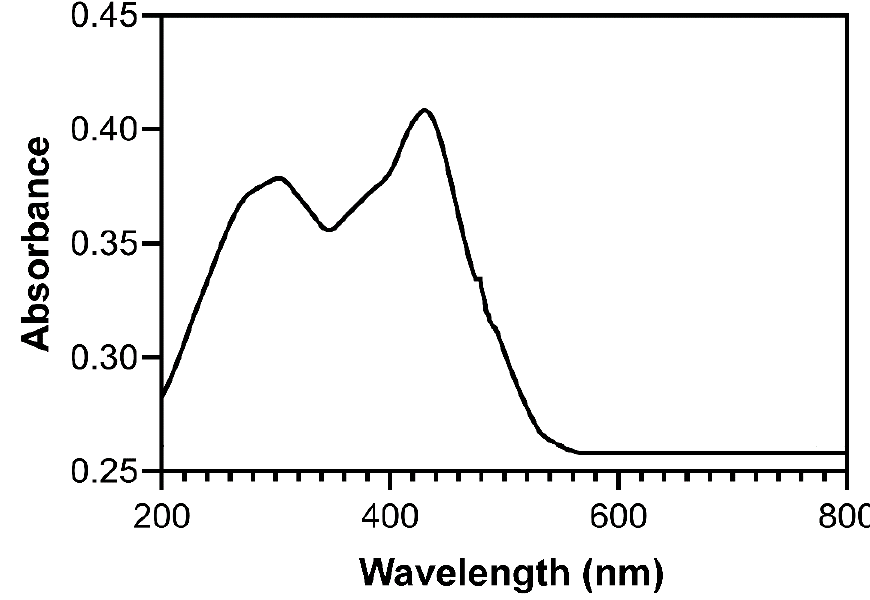
Figure 2. UV absorption spectrum of Ag nanoparticles.